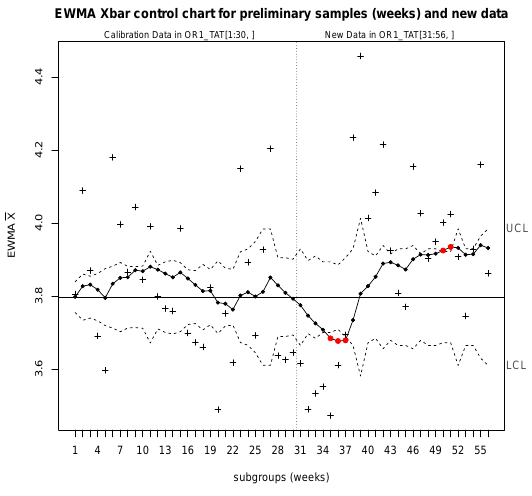
Figure 6 – EWMA control chart for the process mean: preliminary samples (Calibration from week 1 to week 30); new observations (from week 31 to week